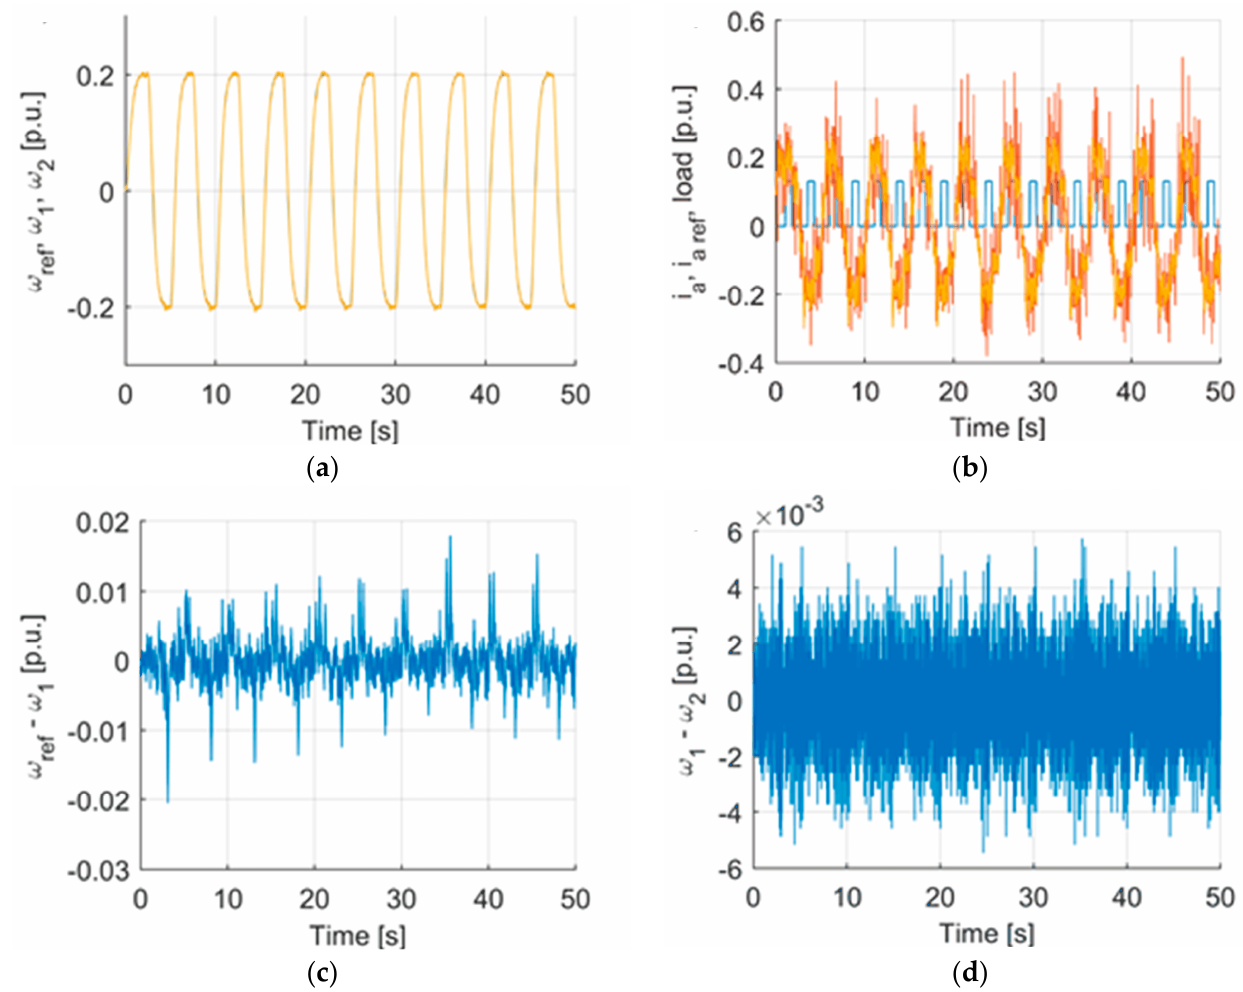
Figure 31. Experimental transients of the system with type II fuzzy controller with Petri layer. Reference (blue), motor (yellow) and load (orange) speed ( a ), reference (orange), measured (yellow) armature current and load level (blue) ( b ), tracking error for motor speed ( c ), difference between machine and load ( d ). Case with variable load.